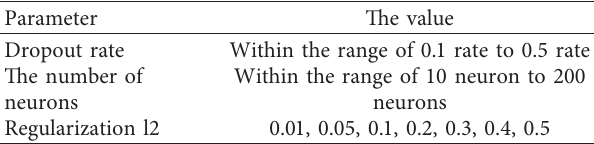
Table 9: Hyperparameters’ configurations selected by Keras